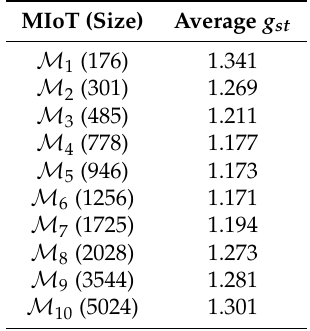
Table 13. Average values of g st against the size of MIoTs (unsupervised approach). MIoT